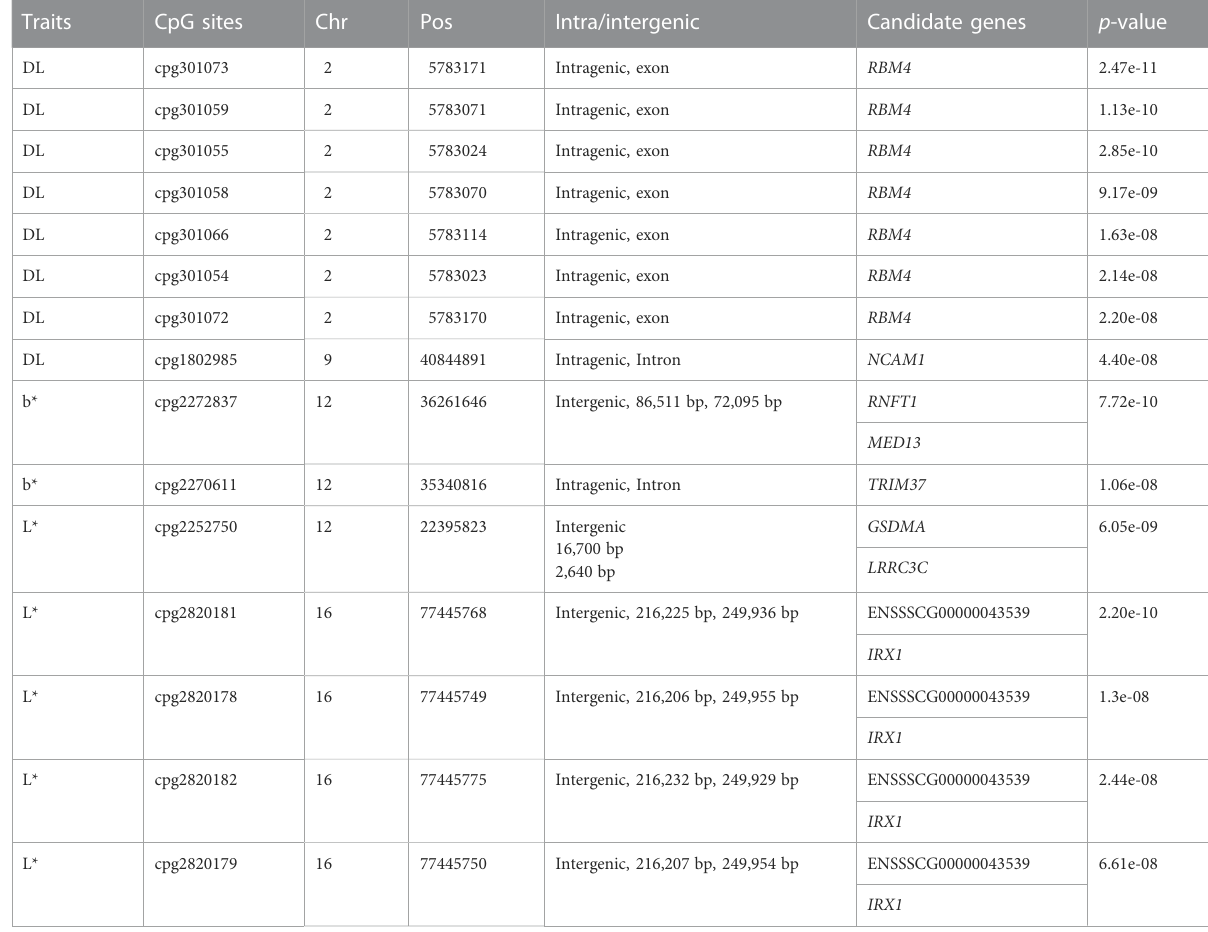
TABLE 2 Summary of signi fi cant CpG sites associated with meat quality